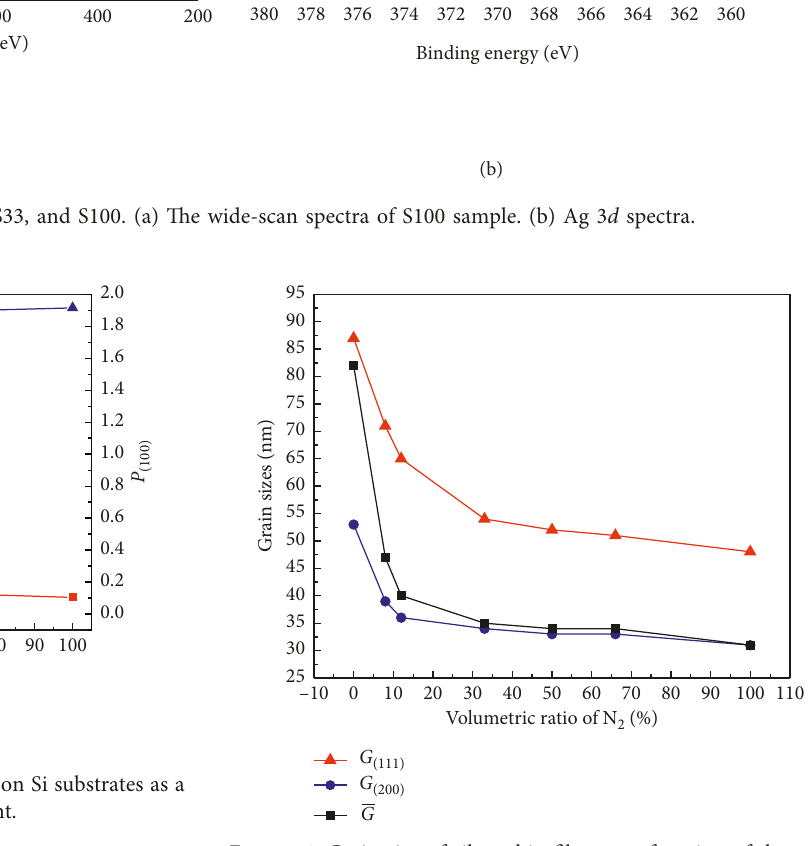
Figure 4: Grain size of silver thin films as a function of the vol- umetric ratio of N 2